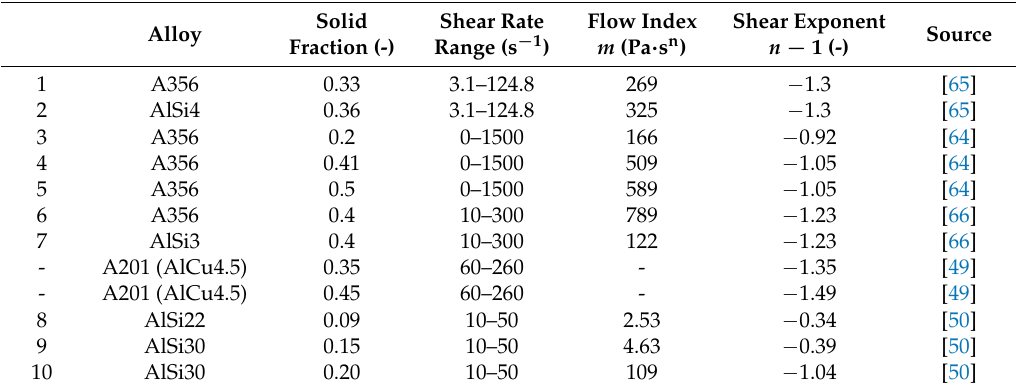
Table 1. Power law parameters from experiments with rheometer for different